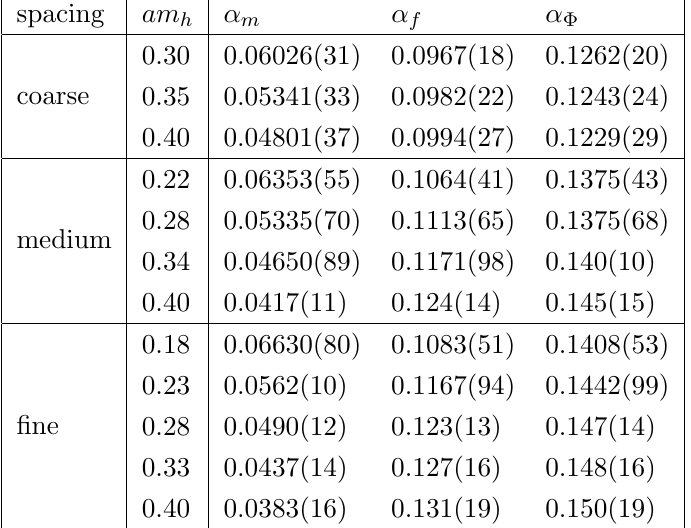
; f D ; (cid:8) D ). Details about how these were s s s